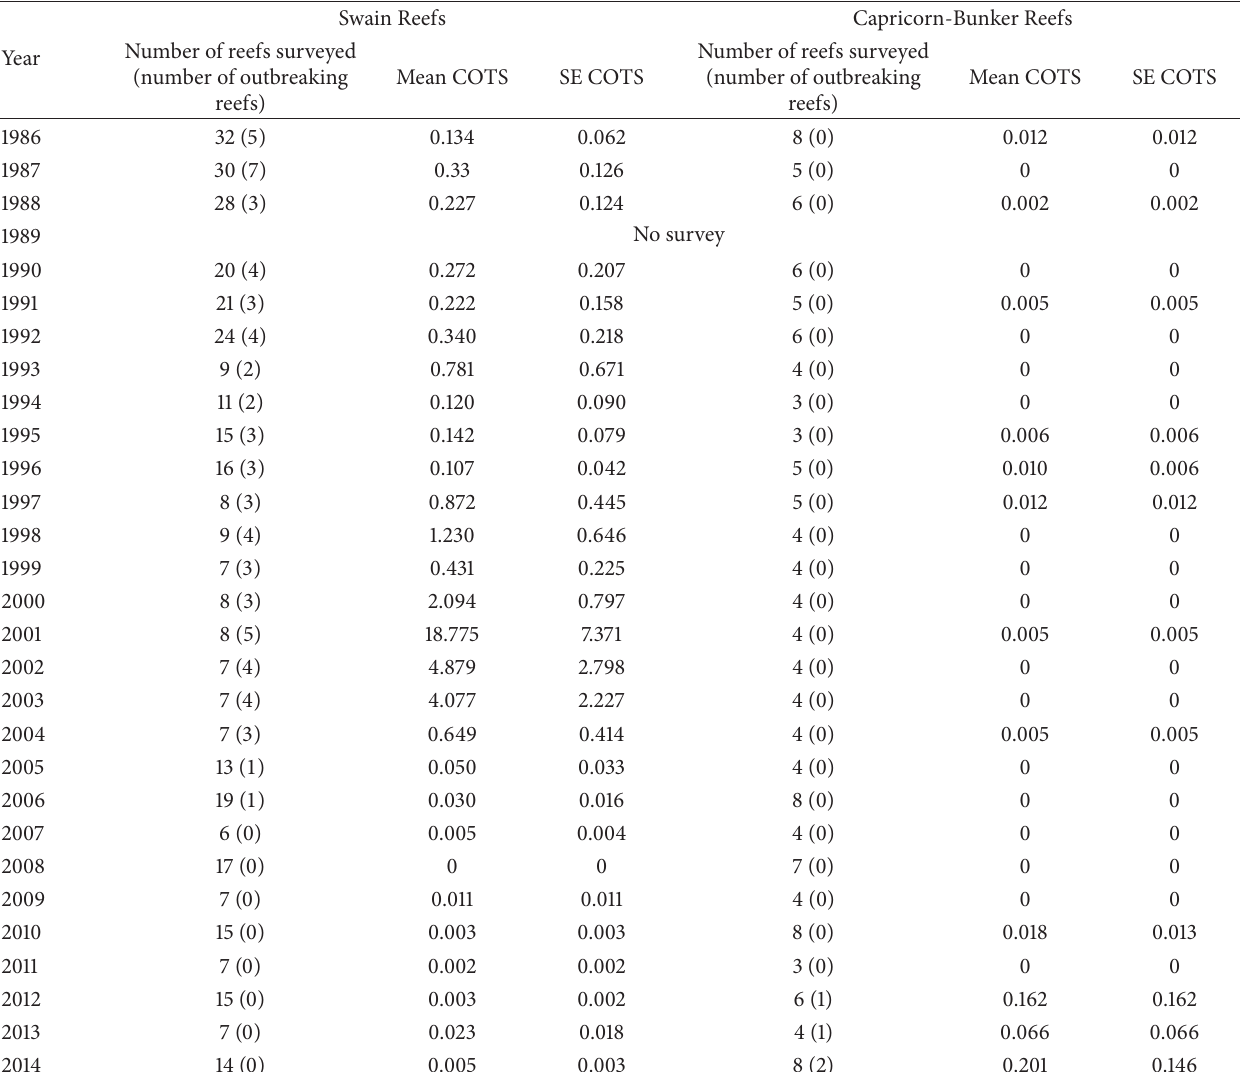
Table 1: Survey year and number of reefs surveyed including the number of reefs recorded with outbreaks in that year (figures given in brackets and include both Incipient and Active Outbreaks combined) in the Swain and Capricorn-Bunker Group. Mean COTS per two- minute tow and standard error (SE) are given for each survey year. A different suite of reefs is sampled in each survey year depending on sample design, weather, and logistical considerations. Survey years run from 1 July of the preceding calendar year to 30 June, so, for instance, the 2012 survey year represents reefs surveyed between July 2011 and June